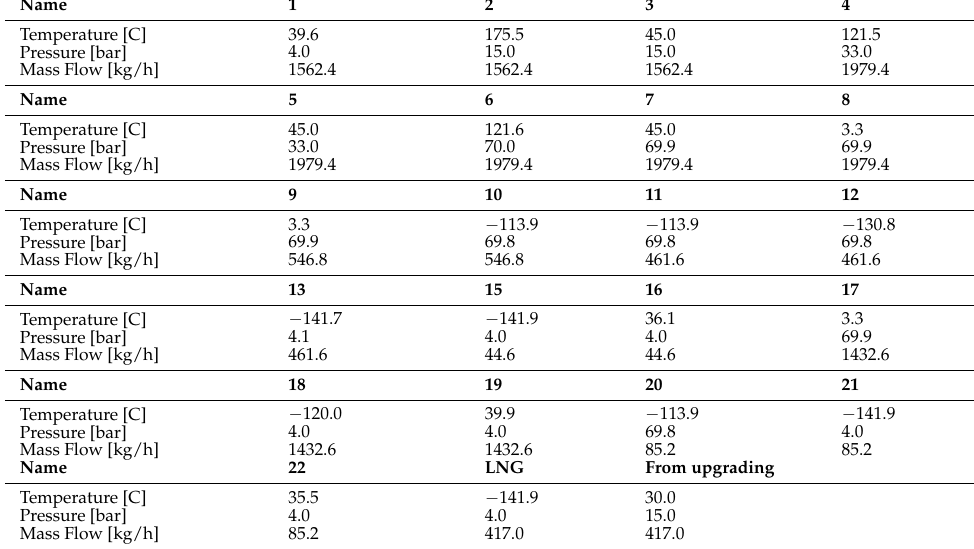
Table A5. States of the biomethane flows in